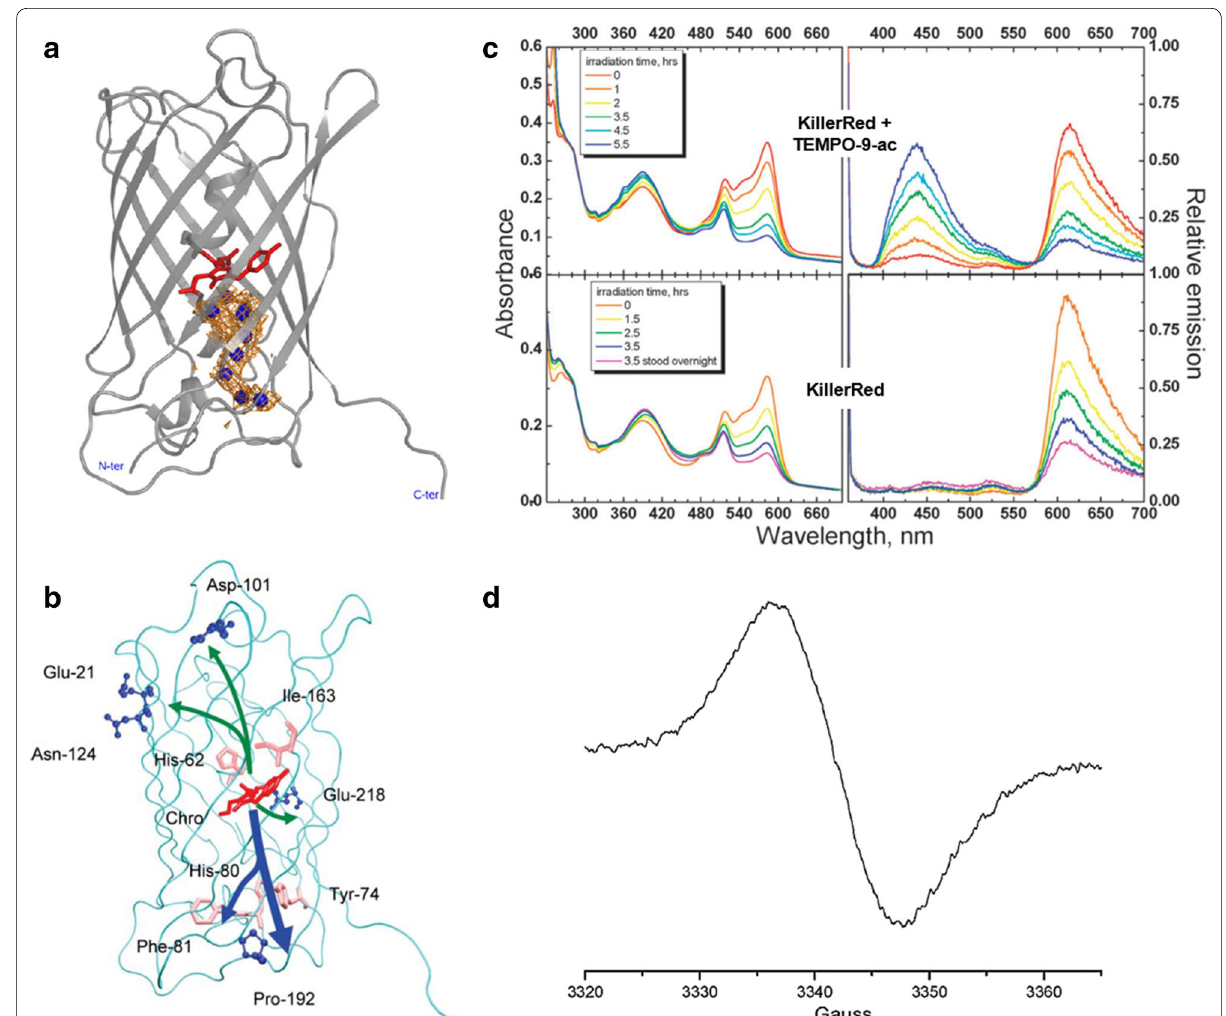
Fig. 6 a 3D structure of a monomer of KillerRed obtained from X‑ray crystallography (Reproduced from [85] with the permission of by John Wiley and Sons Inc.). Monomer A is shown with the backbone represented in gray and the chromophore in red. The cavity forming the channel is shown as the orange isomesh at 1 Å above the van der Walls radius and water molecules in the channel are depicted as the blue spheres. The cleft‑like opening channel filled with water (oxygen) molecules is located in the β ‑barrel frame between β 7 and β 10 sheets. b Possible escape routes for molecular oxygen in the simulations (Reproduced from [86] with the permission of Royal Society of Chemistry). The chromophore is shown in red, the residues at the exits in blue, and other important residues along the pathways in pink. The escape pathways are highlighted by arrows (major channels in blue and minor channels in green). c , d Detection of O 2• ‒ photogenerated from KillerRed (Reproduced from [68] with the permission of Royal Society of Chemistry). c Light absorption (left panels) and emission (right panels) of KillerRed with and without the radical fluorescent